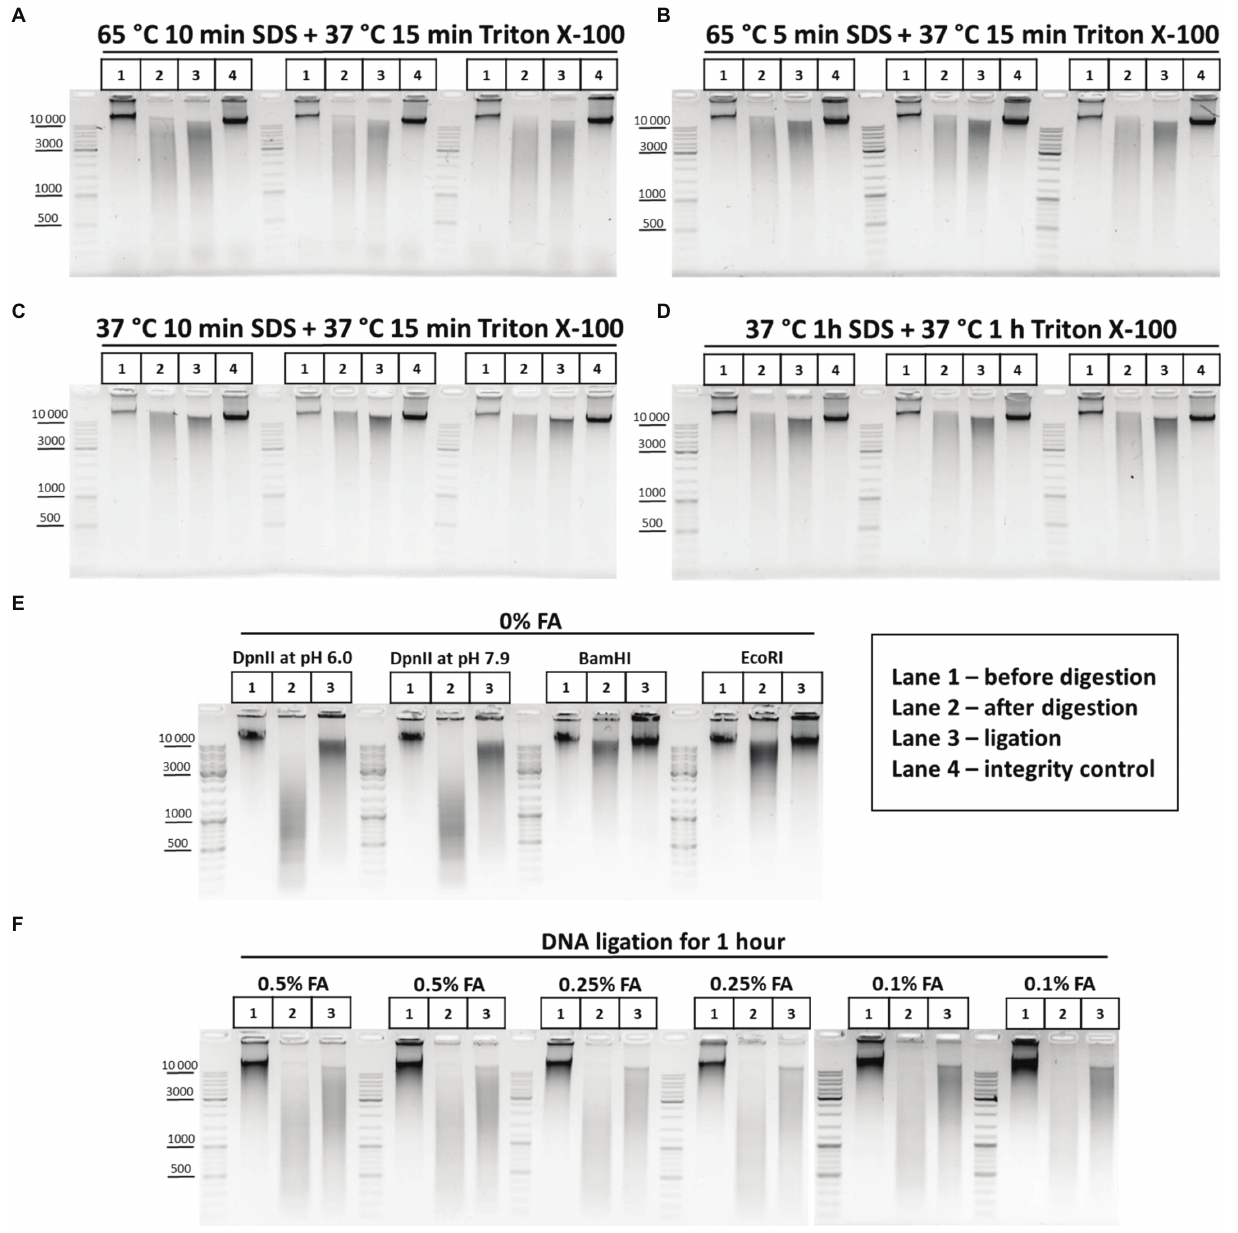
FIGURE 5 | Restriction digestion of DNA in nuclei and in solution. (A – D) Endonuclease digestion of the chromatin in nuclei after different regimens of chromatin treatment. С ells were fixed, quenched, washed after quenching with 1X PBS as in Figures 2A – C and then lysed, incubated in lysis buffer, and washed as in Supplementary Figure S1A . Then, nuclei were resuspended in autoclaved water supplemented with 0.3% SDS and were treated with the SDS and subsequently with Triton X-100 (1.8% final) in the following conditions, as indicated in the figure: (A) 65 ° C for 10 min with SDS + 37 ° C for 15 min with SDS/Triton X-100; (B) 65 ° C for 5 min with SDS + 37 ° C for 15 min with SDS/Triton X-100; (C) 37 ° C for 10 min with SDS + 37 ° C for 15 min with SDS/Triton X-100; and (D) 37 ° C for 1 h with SDS + 37 ° C for 1 h with SDS/Triton X-100. Then, nuclei were centrifuged, supernatant containing SDS/Triton-X100 was removed and nuclei were washed three times with 1X RB (DpnII buffer), and then resuspended in 1X RB and incubated with 2 U/ μ l of DpnII for 3 h at 37 ° C with agitation. Then, nuclei were washed three times with 1X T4 DNA ligase buffer, resuspended in 1X T4 DNA ligase buffer, and incubated with 0.25 U/ μ l of T4 DNA ligase (Sibenzyme) for 30 min at 16 ° C and for 30 min at 22 ° C with agitation. Aliquots of 1/10 of the sample volume were taken after chromatin treatment with SDS/Triton X-100, followed by washing of the nuclei with 1X RB (Lane 1 – undigested chromatin, chromatin integrity control before RE digestion, control #1) and, after restriction reaction, followed by washing with 1X T4 DNA ligase buffer (Lane 2 – digested chromatin, chromatin restriction control after RE digestion, control #2). The volume of samples was adjusted, with 1X T4 DNA ligase buffer, to 250 μ l and PrK, SDS and EDTA were added, as in Supplementary Figure S1A , to the control #1, control #2, and ligation (lane 3) and control #3 (lane 4 – a control of DNA integrity throughout all stages of the procedure – sample that went through the entire procedure without addition of RE and T4 DNA ligase). Cross-links were reversed as in Supplementary Figure S1A and the DNA was extracted, precipitated as in Figures 2A – C , dissolved in 25 μ l for control